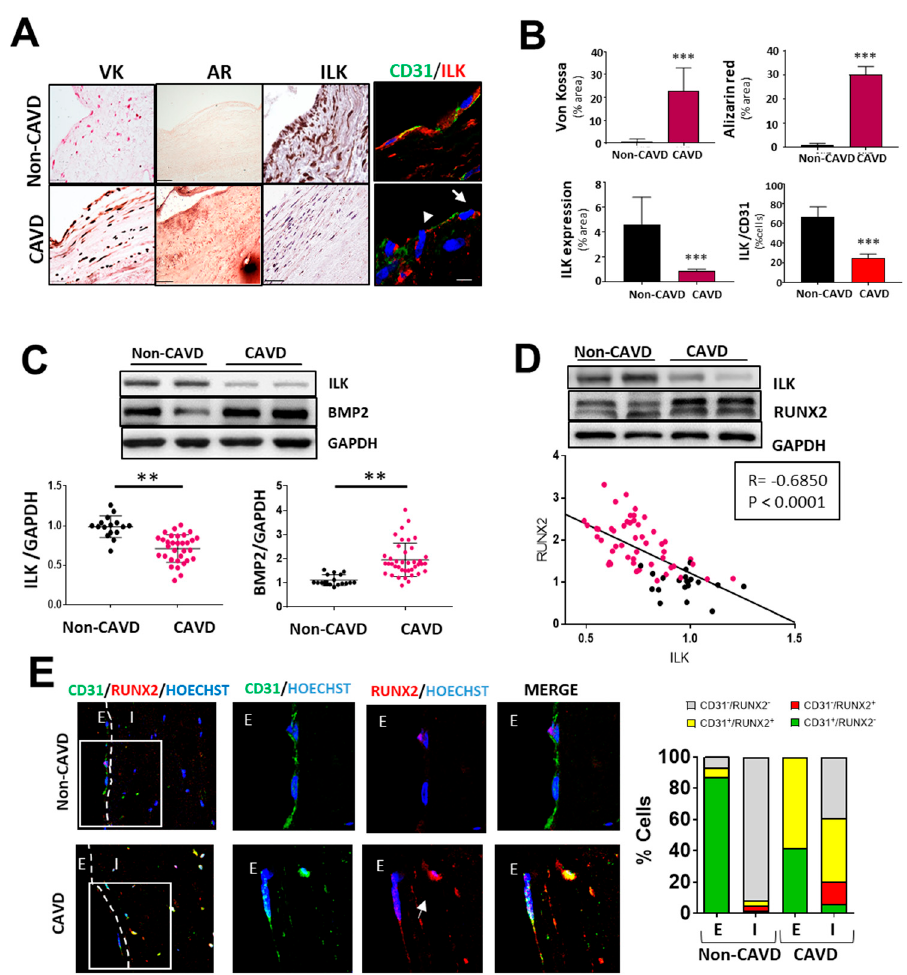
Figure 1. Endothelial ILK is downregulated in calcific aortic valve disease. ( A ) Von Kossa (VK) and Alizarin Red (AR) staining of calcium deposits (left panel); immunohistochemistry of ILK (central panel); and immunofluorescence of ILK in red and the endothelial marker CD31 in green (right panel) in non-CAVD or CAVD human aortic valve leaflets. Nuclei were counterstained with Hoechst. Arrows show valve endothelial cells. Scale bar = 25 µ m. ( B ) Quantification of calcification and ILK expression shown in ( A ). n = 10. *** p < 0.001 vs. non-CAVD. ( C , D ) Western blot analysis of non- CAVD vs. CAVD valve tissue proteins. ( C ) ILK and BMP2 expression and quantification (n = 16–31, ** p < 0.01). ( D ) ILK and RUNX2 expression and Pearson correlation (R = − 0.685, *** p < 0.0001, n = 72). ( E ) Confocal fluorescent microscopy images of CD31 (green) and RUNX2 (red) in non-CAVD and CAVD aortic leaflets. The dotted line delimits the endothelium ( E ) from the interstitium (I). Cell nuclei were counterstained with Hoechst. On the right, magnifications of areas enclosed in white squares. Scale bar = 25 µ m. Arrowheads indicate cells within the valves expressing both markers. Percentages of cells expressing CD31, RUNX2, or both markers are shown on the right. n = 4.